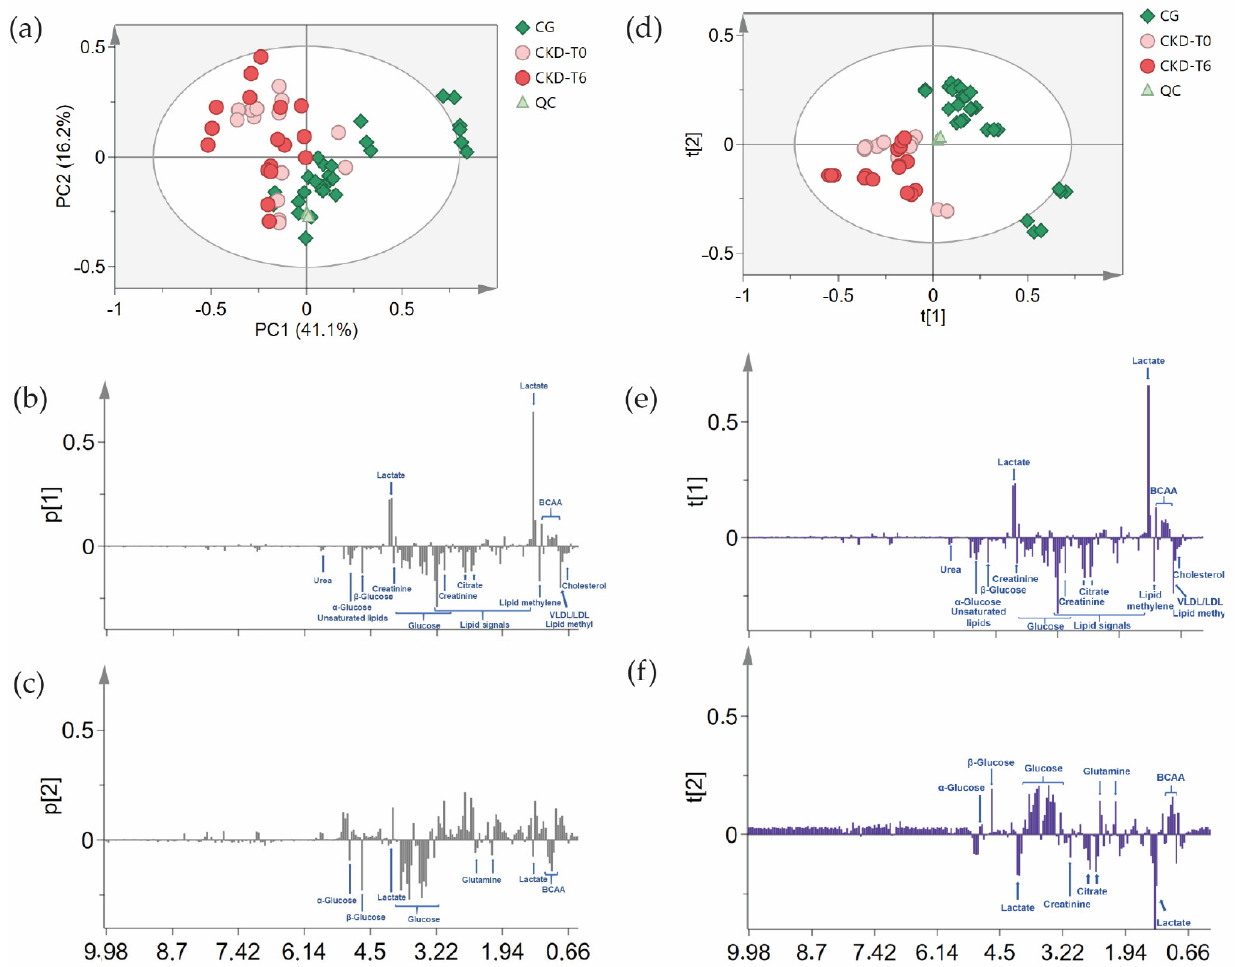
Figure 2. Principal component analysis (PCA) of 1 H NMR data of dogs’ serum. ( a ) PCA score scatter plot of first principal component (PC1) versus second principal component (PC2); ( b ) PC1 loadings column plot of PCA, showing the main metabolites that influenced the separation; ( c ) PC2 loadings column plot of PCA, showing the main metabolites that influenced the separation; ( d ) PLS-DA score scatter plot of axis 1 versus axis 2; ( e ) loadings column plot of axis 1 of PLS-DA; ( f ) loadings column plot of axis 2 of PLS-DA, showing the main metabolites that influenced the separation. CG: control group of healthy animals; QC: quality control; CKD-T0: CKD dogs before being fed a renal diet; CKD-T6: CKD dogs after being fed a renal